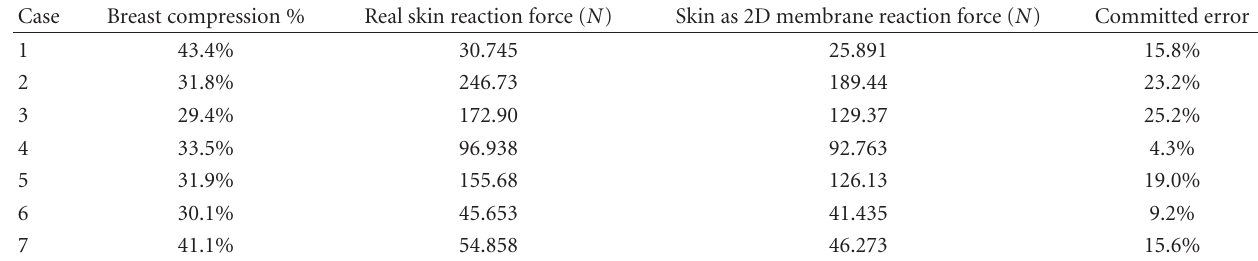
Table 2: Results of the simulation of the breast